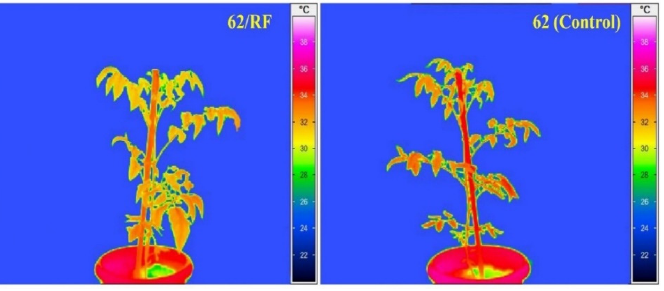
Figure 5. Thermal images of graft 62/RF and control in severe water stress (SWS) conditions.